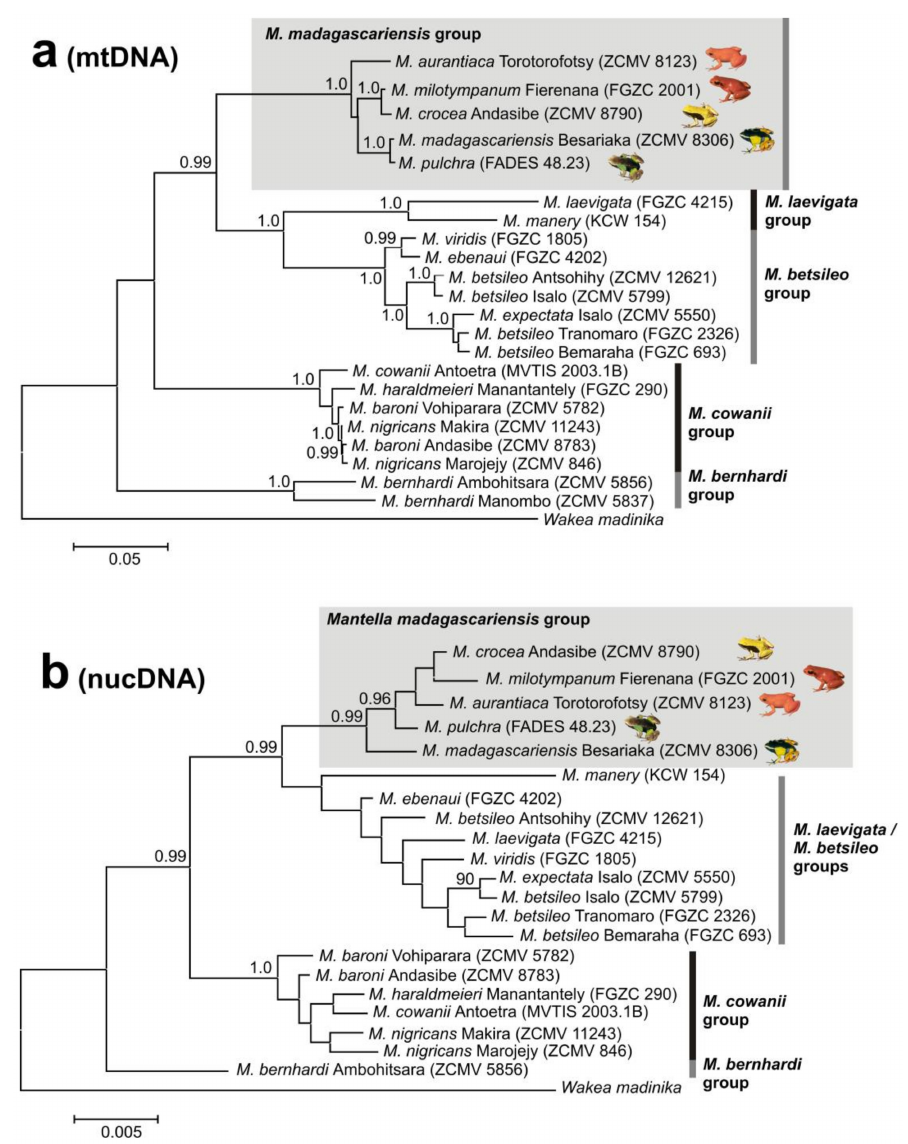
Figure 2. Phylogenetic trees of the genus Mantella , showing the position of the target species in the Mantella madagascariensis group, obtained by Bayesian Inference analysis of ( a ) 2531 bp of four mitochondrial genes ( COB , cytochrome oxidase subunit 1 ( COX1 ), 12S, 16S), and ( b ) 1710 bp of three nuclear genes (recombination activating gene 1 ( RAG-1 ), recombination activating gene 2 ( RAG-2 ), brain-derived neurotrophic factor ( BDNF )). Values at nodes are Bayesian posterior probabilities (not shown if <